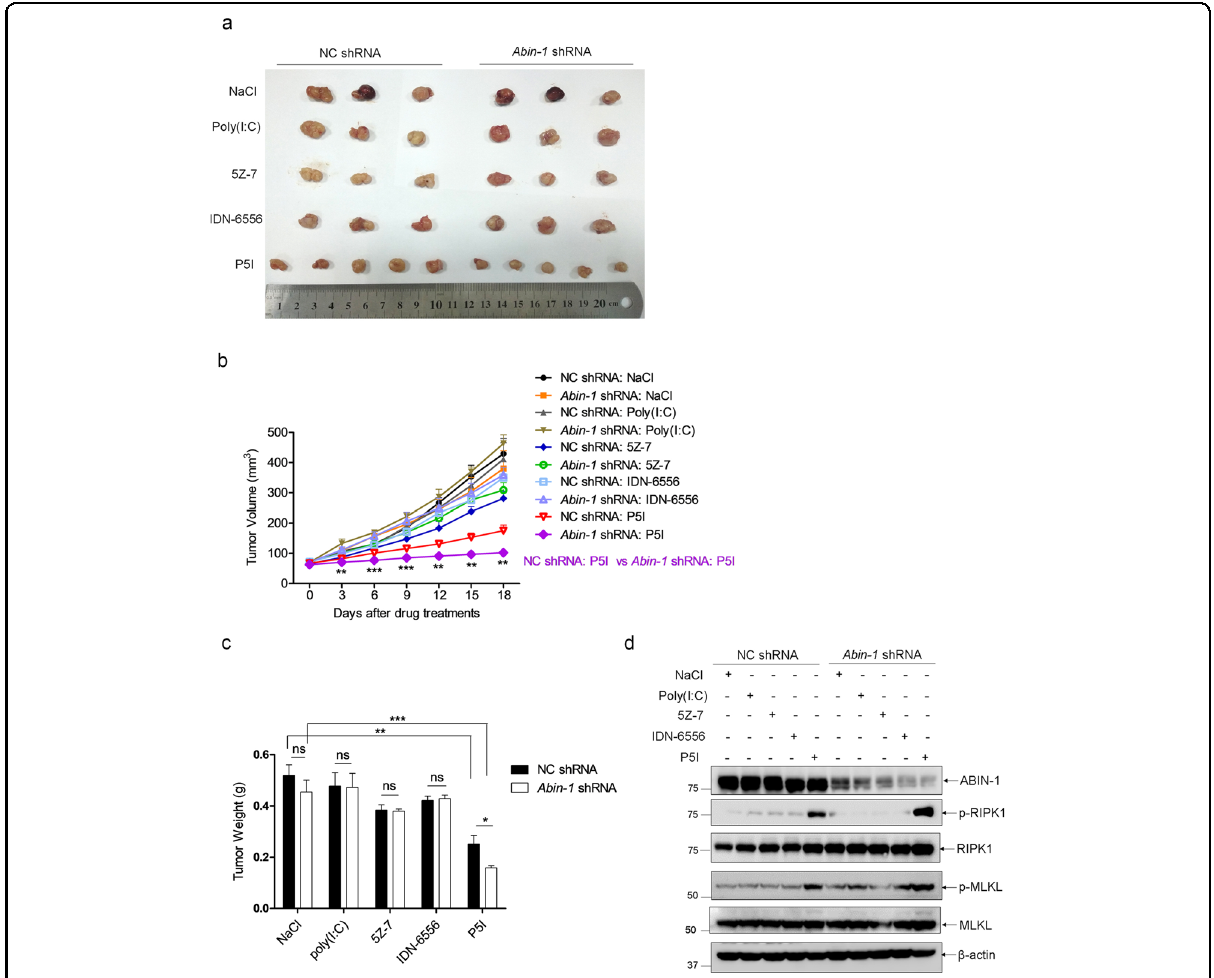
Fig. 6 ABIN-1 de fi ciency improves poly(I:C) + 5Z-7-oxozeaenol + IDN-6556-induced necroptosis cancer therapy. COLO205 cells were transduced with lentivirus-based control shRNA (NC shRNA) or Abin-1 shRNA and screened with puromycin for 5 days to establish stable knockdown pool cells. NC shRNA cells and Abin-1 shRNA cells were subcutaneously injected into the left fl ank and right fl ank of BALB/c nude mice, respectively. When tumors grew to 100 mm 3 , mice were divided into fi ve groups (normal saline (NaCl), n = 3; poly(I:C), n = 3; 5Z-7-oxozeaenol (5Z-7), n = 3; IDN- 6556, n = 3; poly(I:C) + 5Z-7-oxozeaenol + IDN-6556 (P5I), n = 5), Mice were intraperitoneally injected with indicated drugs every 3 days. Tumor volumes were measured every three days, and mice were sacri fi ced 18 days after the fi rst drug injection. Tumors were isolated for imaging, weighing, and western blot analysis. Poly(I:C), 5 mg/kg; IDN-6556, 1.25 mg/kg; and 5Z-7-oxozeaenol, 0.6 mg/kg. a Tumors images. b Tumor volumes. Volume (mm 3 ) = 0.5 × length (mm) × width 2 (mm 2 ). c Tumor weights (g). d Western blot analysis for necroptosis markers. Each lane was loaded with a randomly selected tumor sample from each group. * P < 0.05, ** P < 0.01, or *** P <